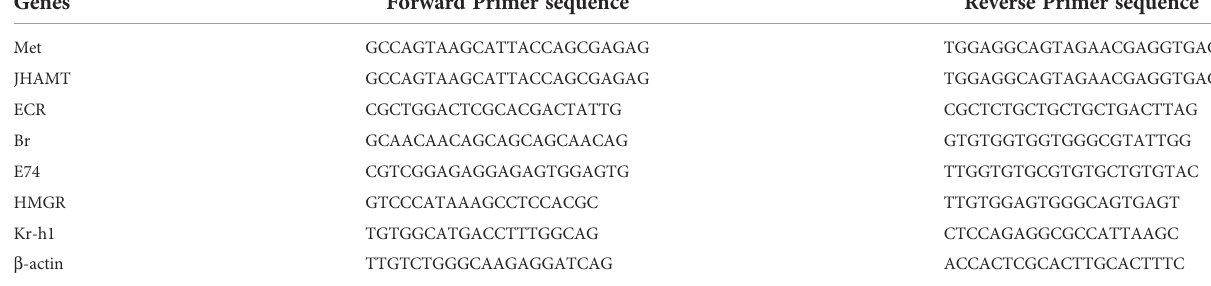
TABLE 1 Primer sequences used for quanti fi cation of gene